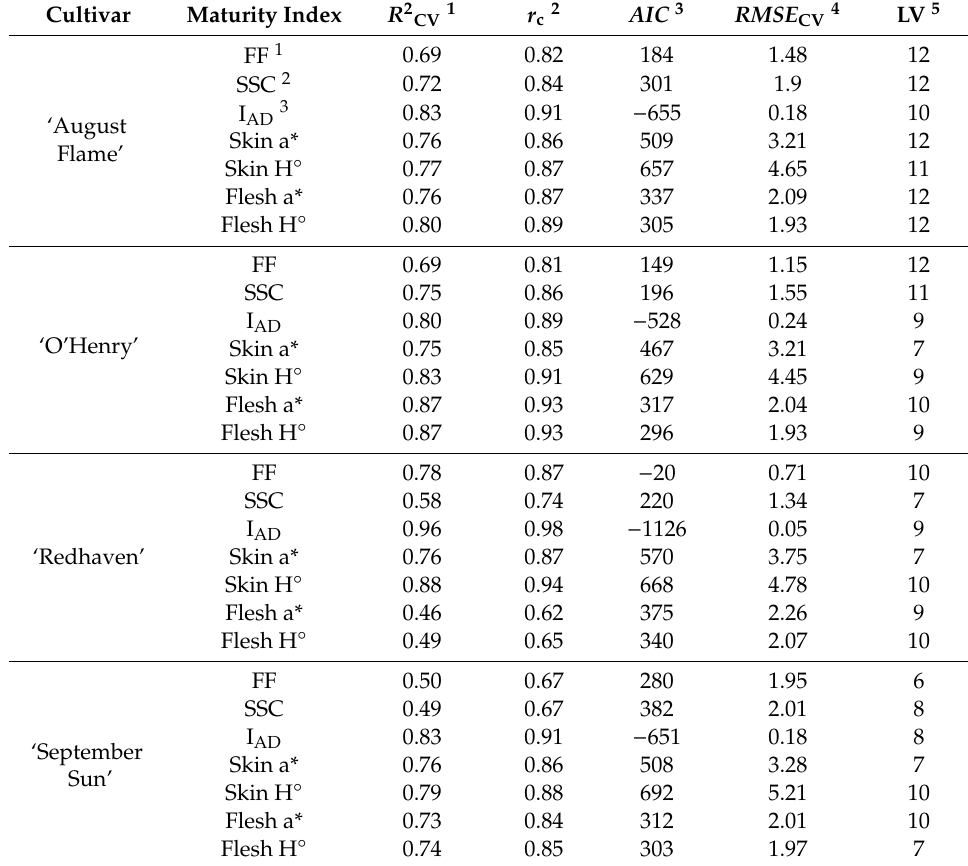
1 Coe ffi cientofdeterminationofthecross-validation, 2 Lin’sconcordancecorrelationcoe ffi cient, 3 Akaikeinformation criterion, 4 root mean square error of the cross-validation and 5 number of latent